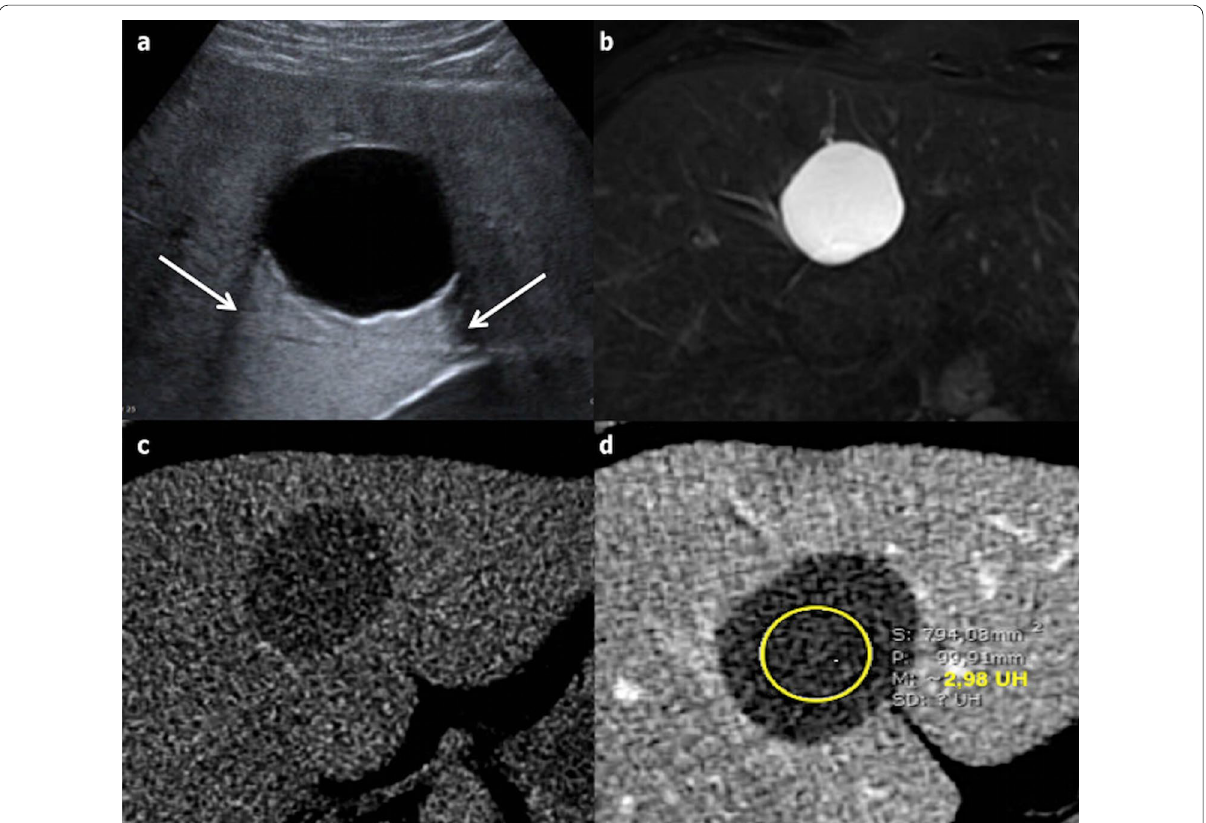
Fig. 3 Incidentally found simple hepatic cyst in an asymptomatic 64-year-old male. a Ultrasonography shows a round homogeneous anechoic cystic hepatic lesion, well-circumscribed and without any mural nodule or vegetation. The arrows show an increased through transmission, confirming the cystic nature of the lesion. b T2-weighted magnetic resonance imaging shows a highly hyperintense round lesion. c and d Computed tomography without and with contrast on portal venous phase shows a round homogeneous non-enhancing hypoattenuating lesion (3 Hounsfield